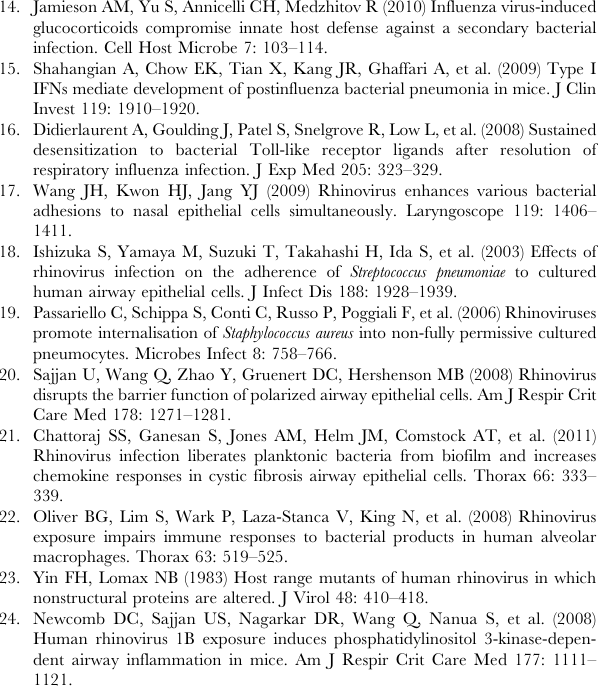
Figure S3 Gene specific siRNA to TLRs inhibits protein expression of respective TLRs. BEAS-2B cells were reverse transfected with NT-, TLR2, TLR4, TLR5, TLR7 or TLR8. After 48 h incubation, cells were either permeabilized (for TLR7 and TLR8) or not (TLR2, TLR4 and TLR5), incubated with antibodies to (A) TLR2, (B) TLR4, (C) TLR5, (D) TLR7 or (E) TLR8 or normal IgG conjugated with FITC and analyzed by flow cytometry. Image is a representative example of 2 independent experiments. (TIF) Figure S4 Knockdown of TLR2 decreases NTHi-stimulated IL- 8. BEAS-2B cells reverse transfected with NT- or TLR2 siRNA were grown for 2 days. Cells were infected with NTHi or sham infected with media, incubated for 3 h at 37 u C and IL-8 the medium was determined. Data represents mean 6 SEM calculated from 3 independent experiments performed in triplicates (* p # 0.05, ANOVA, different from media control; # p # 0.05, ANOVA, different from cells transfected with NT siRNA and then infected with NTHi).